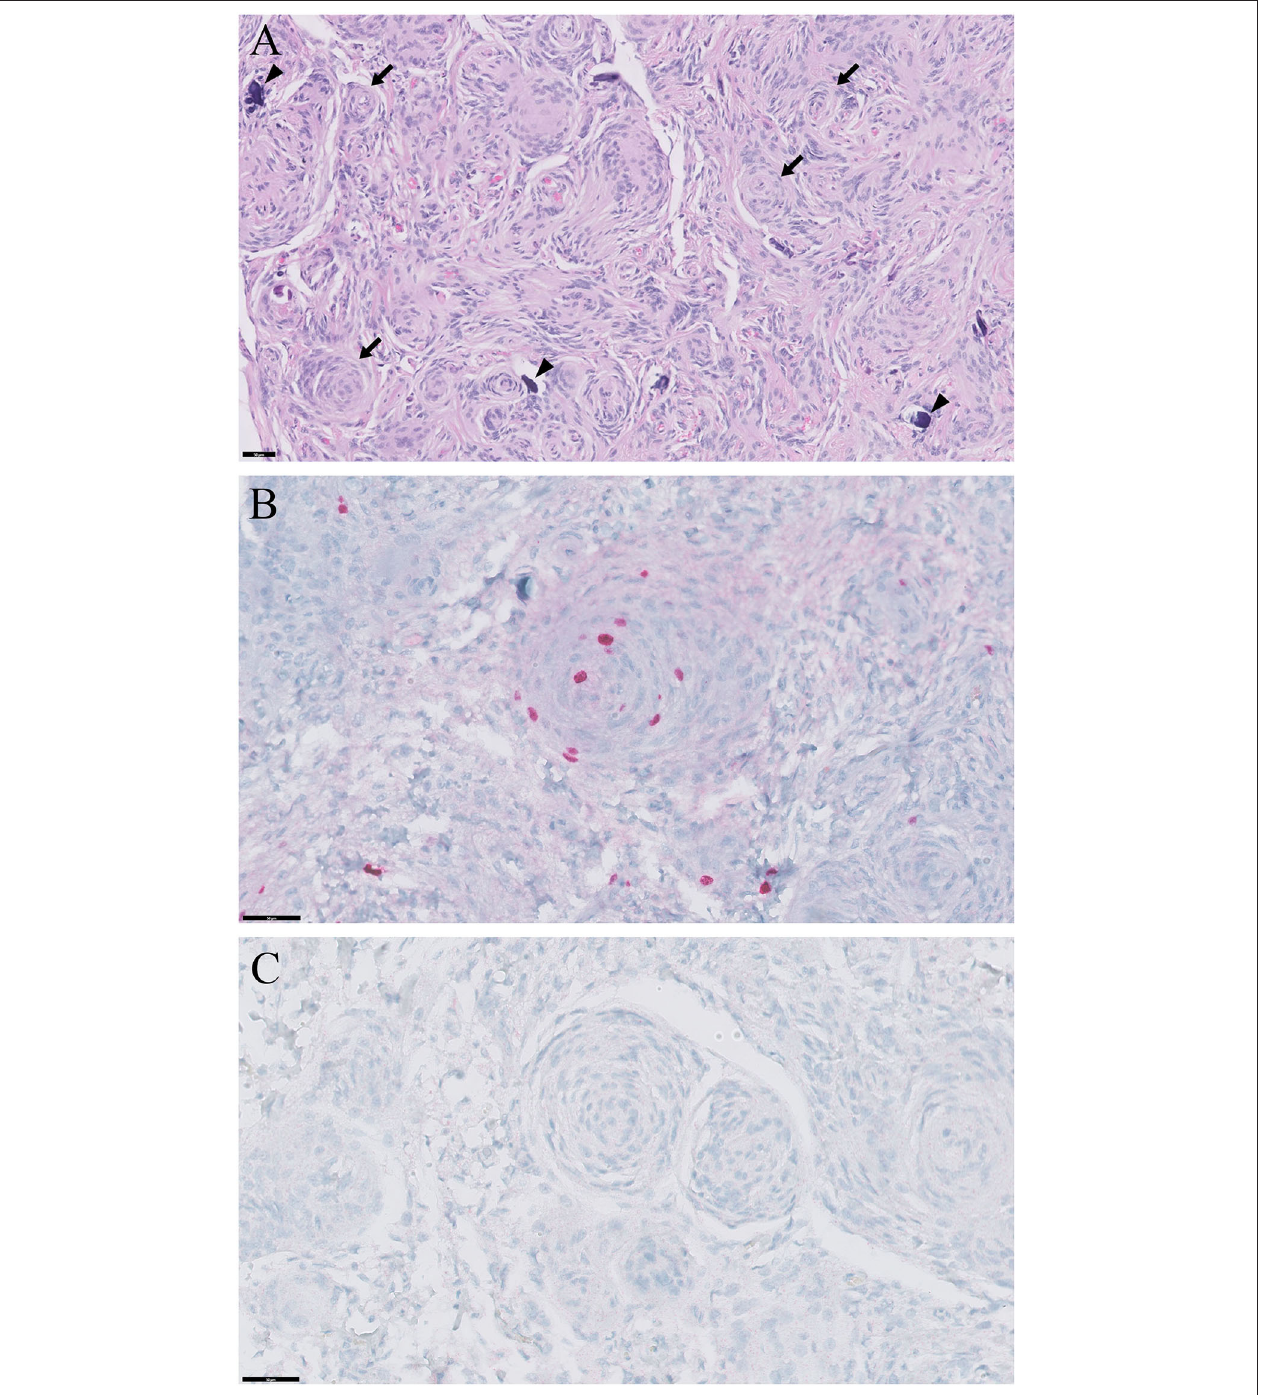
FIGURE 3 | Histopathological and immunohistochemical findings of meningioma in a cat. (A) Extensive concentric whorls (arrows) of polygonal to oblong cells, and spindle shaped cells with interlacing bundles of fibroblast-like cells are observed. Some psammoma bodies (mineralized concretions; arrowheads) are scattered throughout the mass. Hematoxylin and eosin; × 200 magnification; bar = 50 µ m. (B) Positive immunoreactivity to Ki-67. Hematoxylin and eosin; × 400 magnification; bar = 50 µ m. (C) Negative immunoreactivity to p53. Hematoxylin and eosin; × 400 magnification; bar = 50 µ